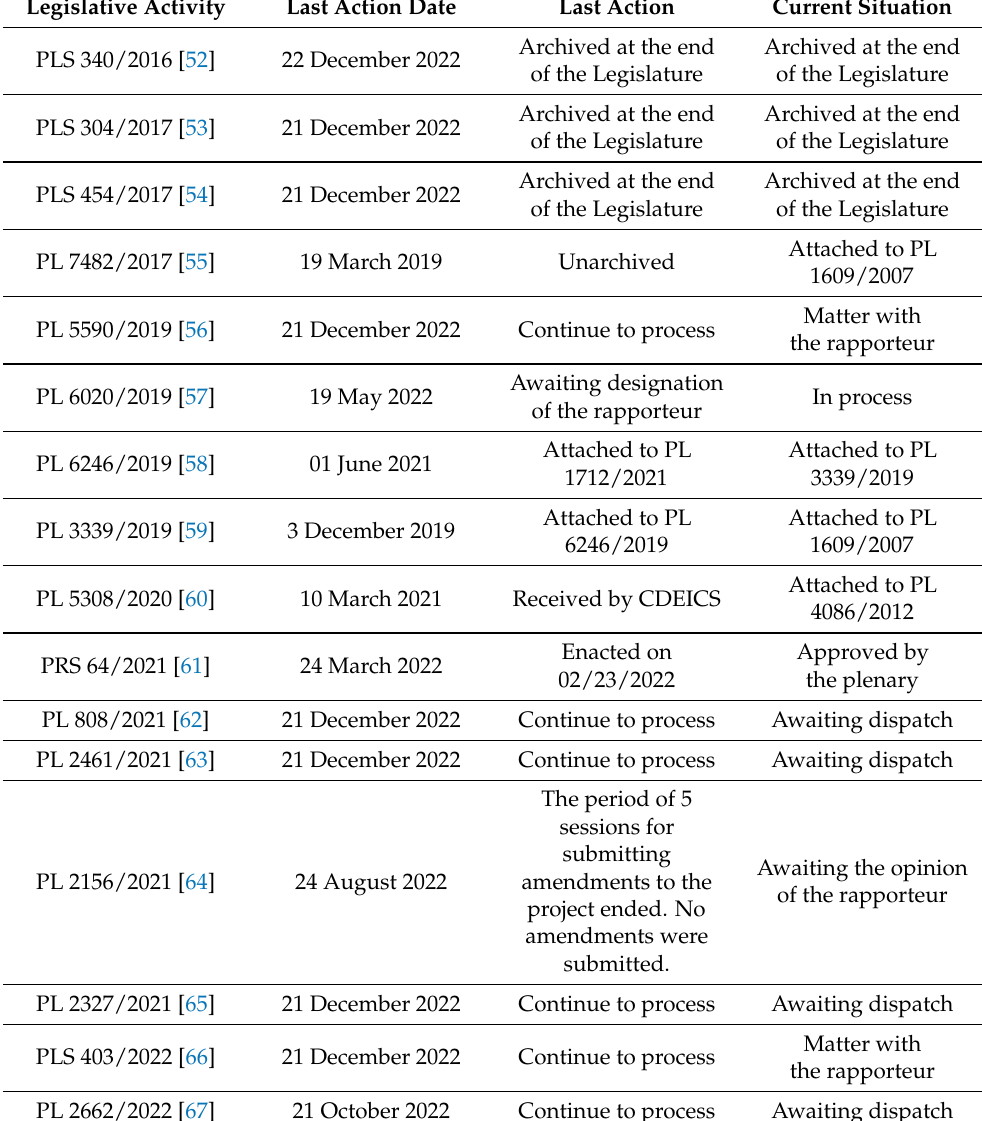
Table 2. Legislative activities